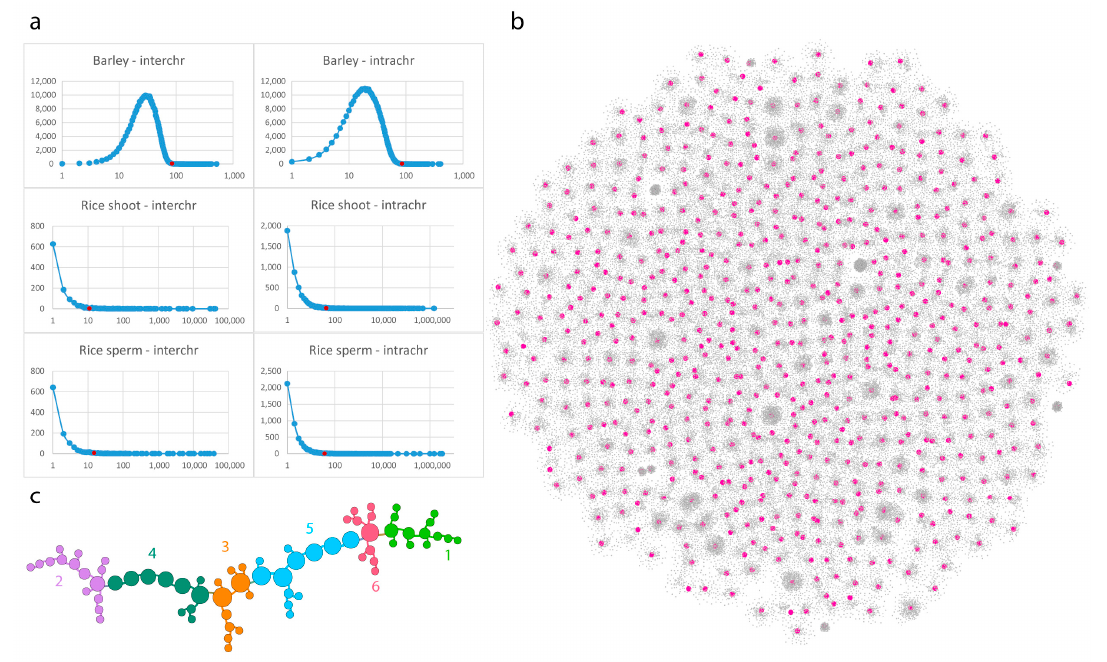
Figure 2. Contact graph construction and analysis. ( a ) Contacts per bin distribution of selected Hi-C libraries. The curve shows the number of bins that have a given contact count. The x -axis is logarithmic, and shows contact count; the y -axis is linear and shows the number of bins. On the charts, a red dot shows the cut-off value for each analysis (see numbers in the Section 2 of the manuscript). For further downstream analysis, only bins that have a frequency of this value or higher were used. In all cases, self-loops were discarded and not counted. ( b ) A 2D representation of interchromosomal filtered contacts of barley (See methods). Magenta nodes represent bins that have 14, or more than 14, edges in the graph. The layout indicates that contacts between the non-homologuous chromosomes are organized by dedicated genomic regions, suggesting hierarchical genomic structures. ( c ) The largest subgraph after filtering for bins of 14 or more different contacts. An intriguing linear layout of contacts has emerged, suggesting a signal transduction “highway” that might function like Newton’s cradle. Colors represent the clusters of the graph. The clusters were characterized by gene enrichment analysis which revealed housekeeping genes within the regions represented by the